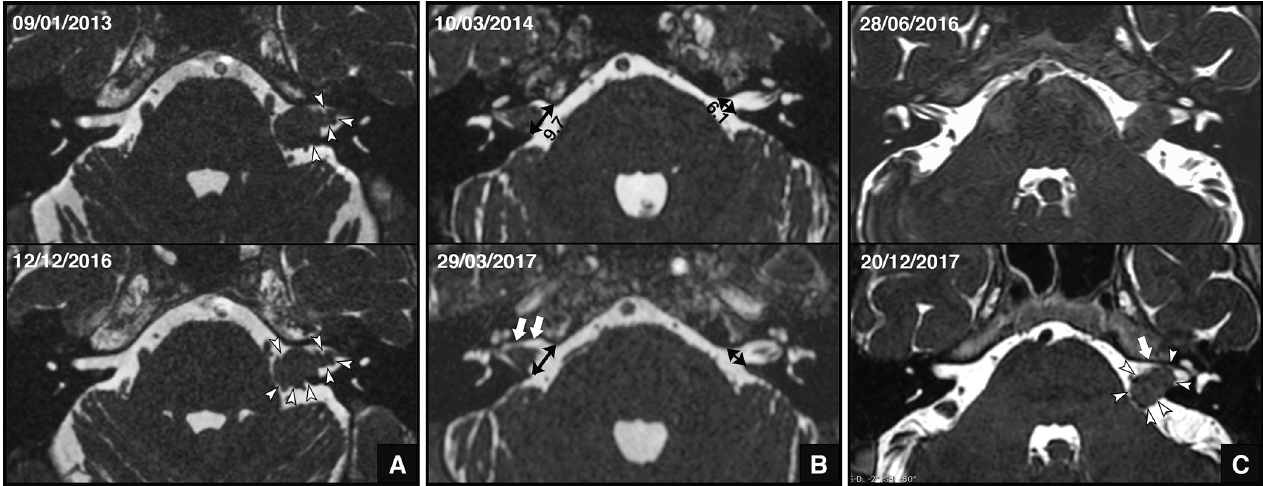
Fig 4. MRI aspect of shrinking tumors (HRT2-weighted imaging). A) First and last MRI of patient 5 that shows the festooned appearance (arrowheads). B) First and last MRI of patient 7 that shows the appearance of CSF infilling the IAM and the asymmetrical size of IAM (large arrows). Measurements are in mm and did not change between the first and last MRI. C) First and last MRI of patient 13: arrows indicate the festooned appearance and large arrows indicate CSF infilling the